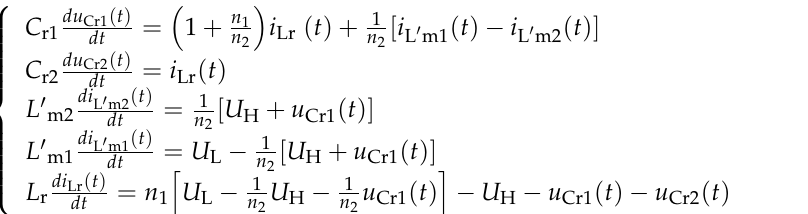
− − ( a ) ( b ) − − − ( c ) Figure 6. Simulation waveforms in step-down mode, 400 V, 1 Ω : ( a ) 90 kHz; ( b ) 120 kHz; ( c ) 160 kHz. − −